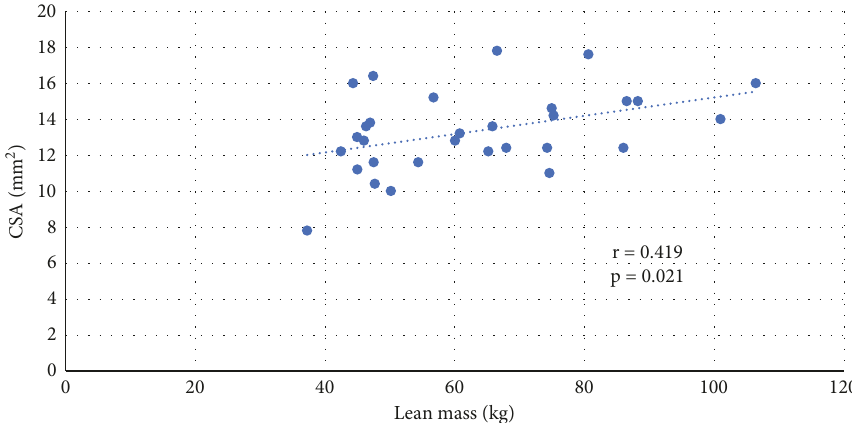
Figure 2: Correlation between lean body mass and the CSA of the median nerve in acromegalic patients.